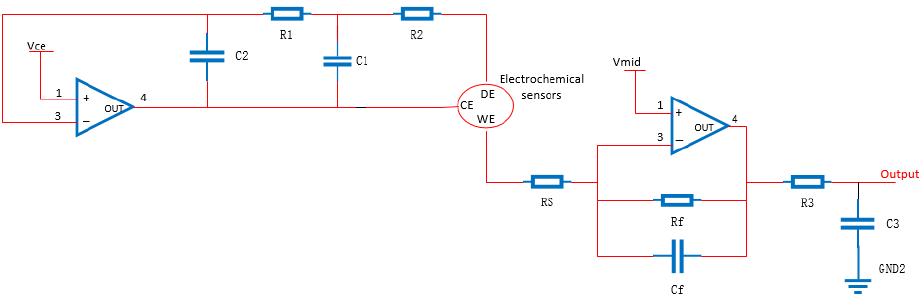
Figure 3. Classic conditioning circuit